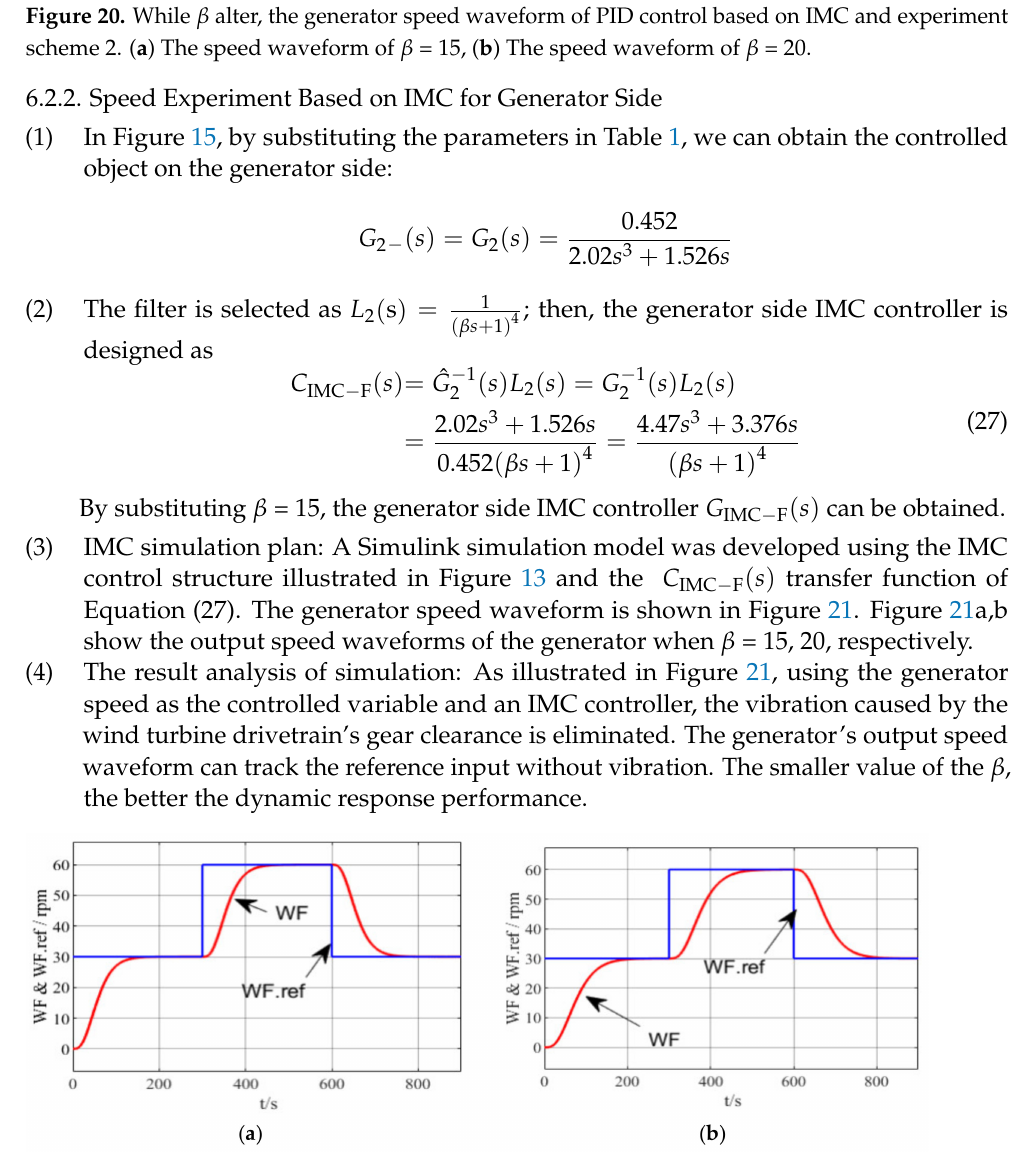
Figure 21. While β alter, the generator speed waveform based on IMC. ( a ) The speed waveform of β = 15; ( b ) The speed waveform of β =